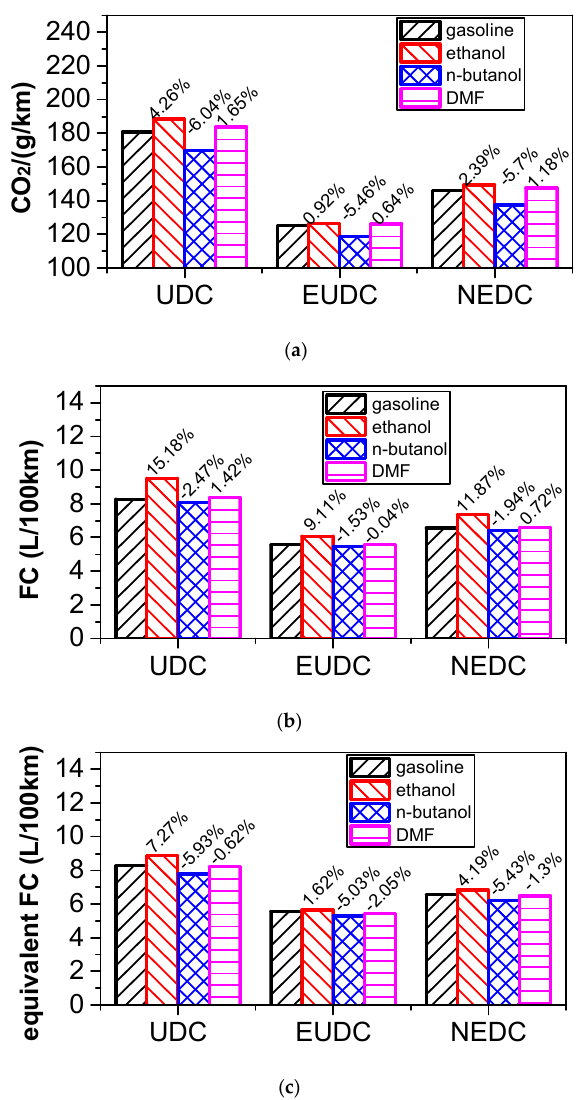
Figure 11. Comparison of CO 2 , volumetric fuel consumption (FC), and equivalent fuel consumption of E20, B20, D20, and gasoline: (a) CO 2 emissions ; (b) Volumetric FC; and (c) Equivalent FC.